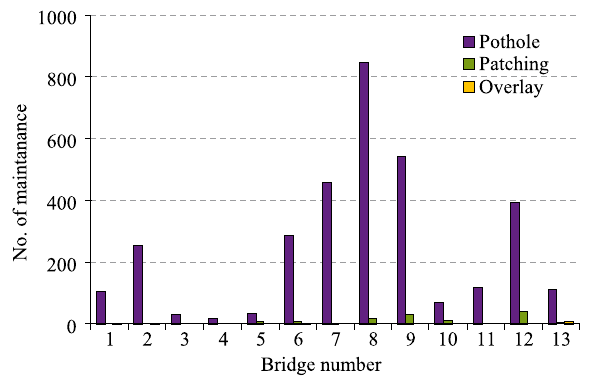
Fig. 1. Primary types of distress observed from bridge deck pavements in Seoul